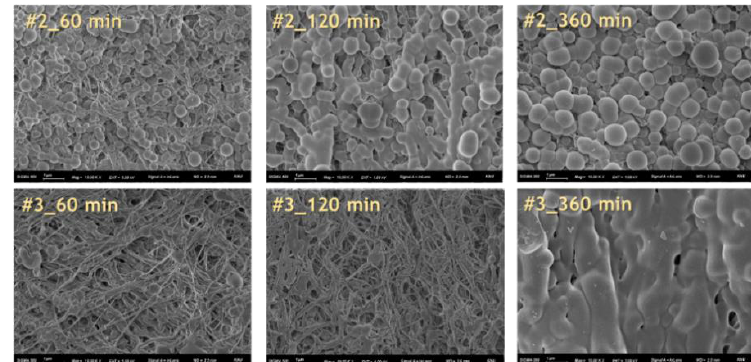
Figure 7. SEM images of the surface on the Zeus PTFE substrates after hydrophilic coating (GA/#2 in the top row and GA/#3 in the bottom